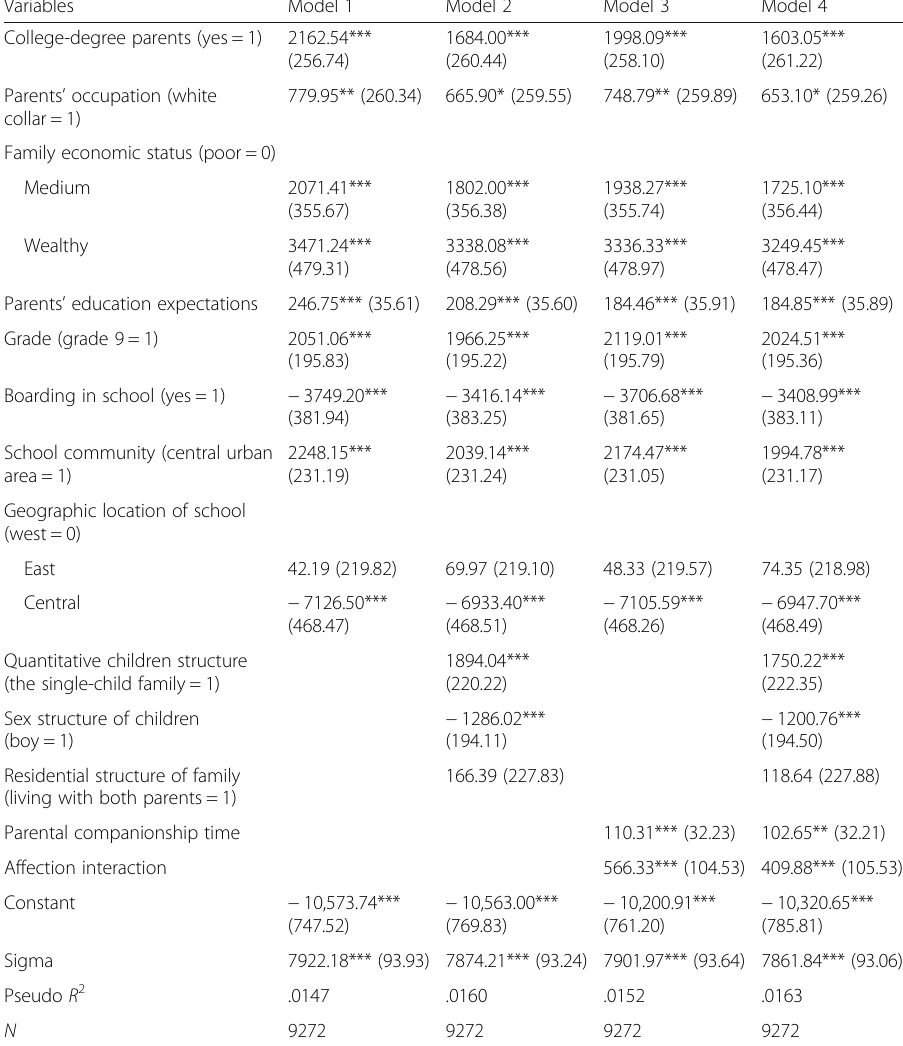
Table 3 Tobit regression model of supplemental education consumption Variables Model 1 Model 2 Model